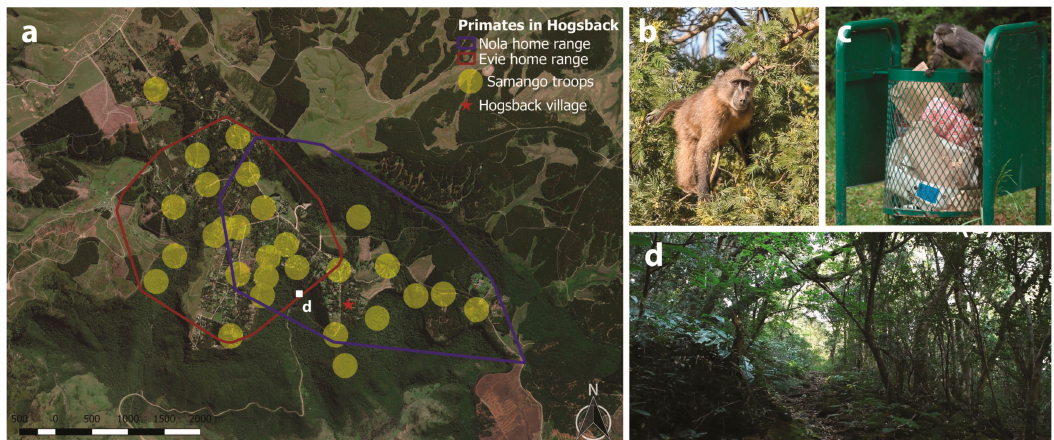
Figure 8. Baboon and samango troops living in Hogsback: ( a ) Distribution map; each yellow circle represents a samango troop core area; red and blue polygons represent the maximum home range extension for the two baboon troops studied over 10 years. ( b ) Juvenile baboon on black wattle tree ( Acacia mearnsii ); ( c ) samango monkey eating from an uncovered trash bin; and ( d ) indigenous